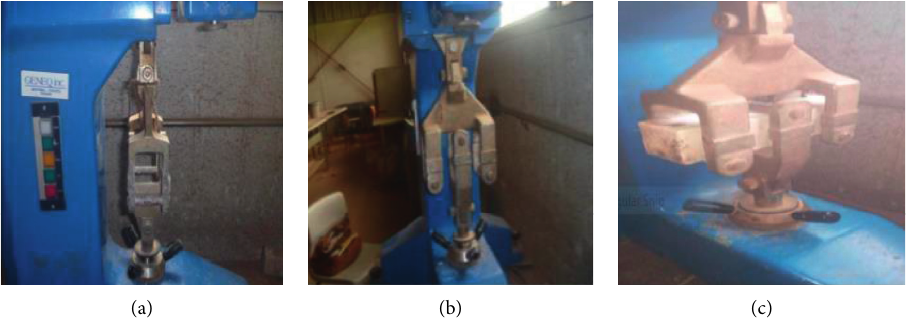
Figure 1: Face views of the flexural test machine. (a) Face view. (b) Side view. (c) Loading